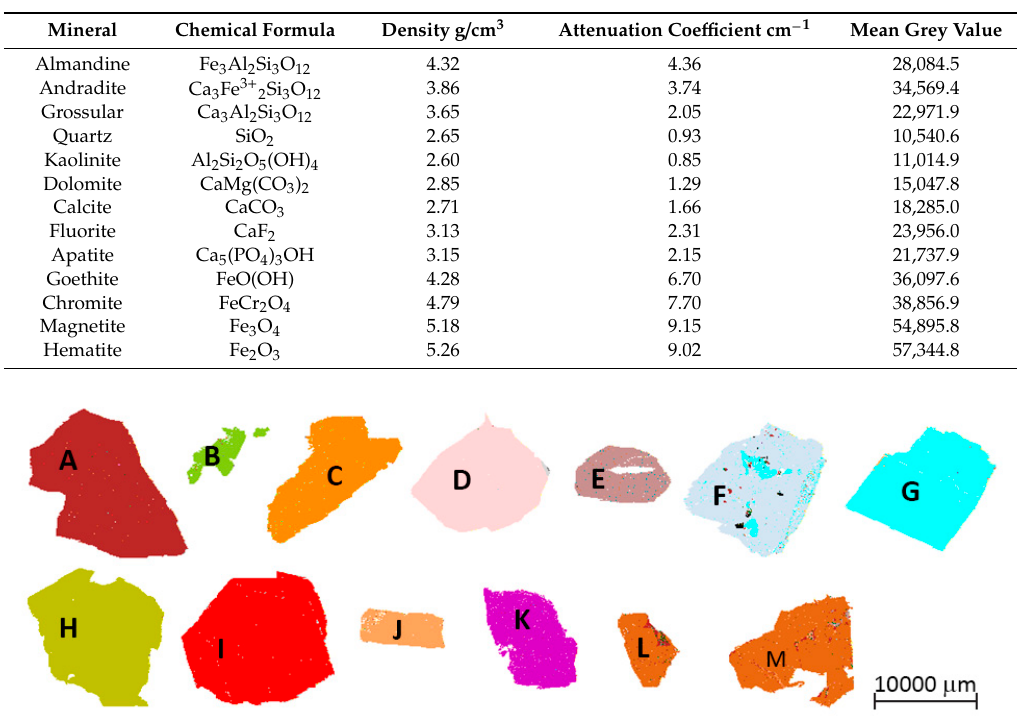
Figure 7. Mineral classification using QEMSCAN in order to understand the discrimination between the minerals: ( A ) almandine, ( B ) andradite, ( C ) grossular, ( D ) quartz, ( E ) kaolinite, ( F ) dolomite, ( G ) calcite, ( H ) apatite, ( I ) fluorite, ( J ) goethite, ( K ) chromite, ( L ) magnetite and ( M ) hematite. False colour image (refer also to Figure 6). Table 4. Mineral discrimination using linear attenuation coefficient difference at 45.5 keV effective energy in conjunction with grey value and density difference. BH = beam hardening.